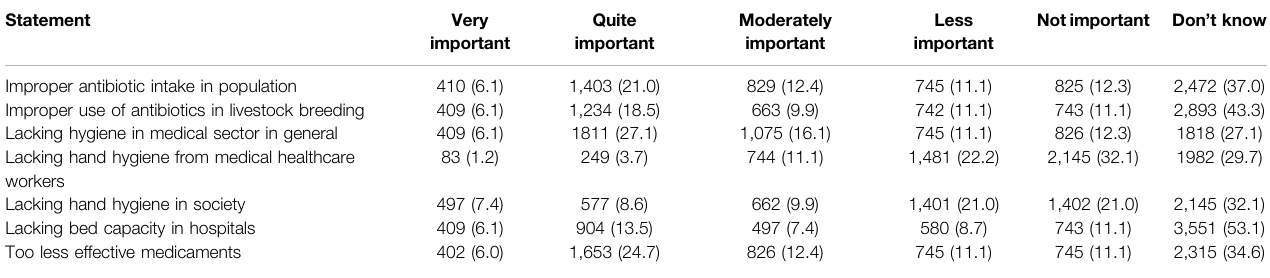
TABLE 2 | Causes you think important for distributions of MDR